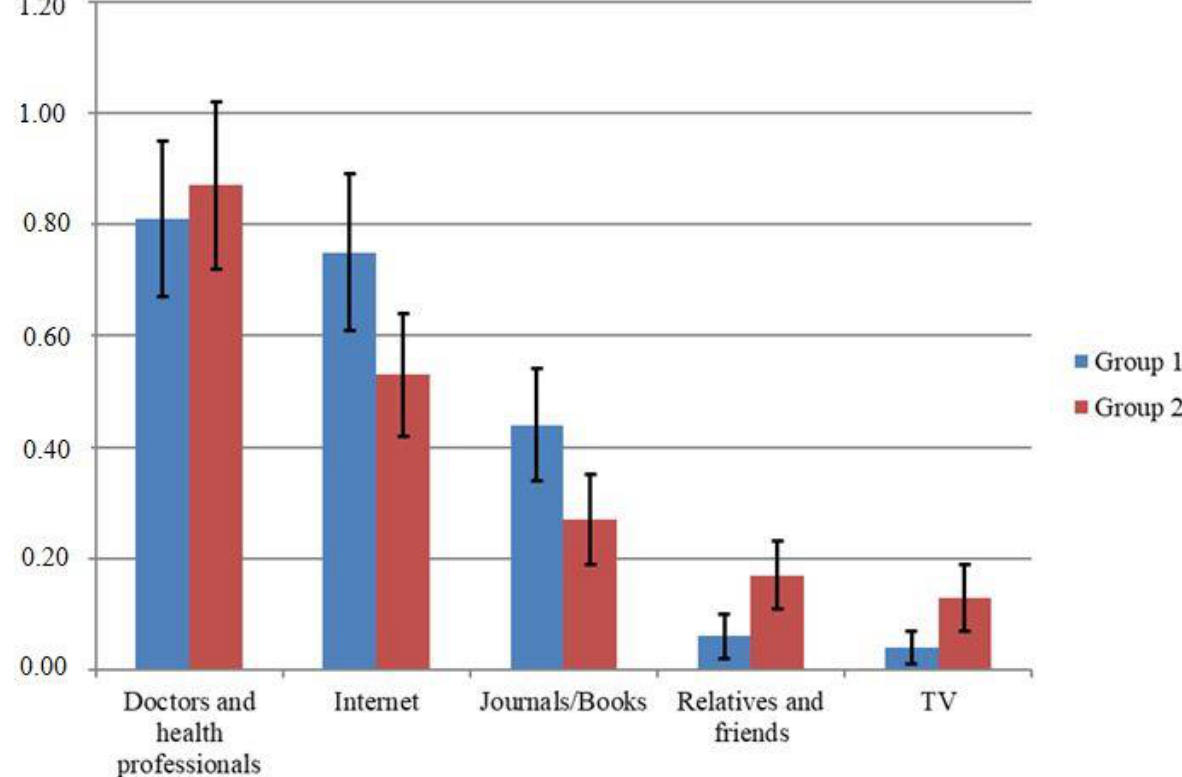
Figure 1. Sources sought for information about memory, dementia, and Alzheimer’s disease: proportion of answers. Question: “What is most important to get information about memory, dementia and Alzheimer’s disease?”- Answers: 1 — Doctors and health professionals (n :N =39; proportion=0.81; 95%CI 0.67– 0.95 vs. n :N =26; proportion =0.87; 95%CI 0.72–1.02; p=0.49). 2 — Internet (n :N =36; proportion=0.75; 95%CI 0.61–0.89 vs. n :N =16; proportion=0.53; 95%CI 0.42–0.64; p=0.04). 3 — Journal/books (n :N =21; proportion=0.44; 95%CI 0.34–0.54 vs. n :N =8; proportion=0.27; 95%CI 0.19–0.35; p=0.13). 4 — Relatives and friends (n :N =3; proportion=0.06; 95%CI 0.02–0.1 vs. n :N =5; proportion=0.17; 95%CI 0.11–0.23; p=0.19). 5 — TV (n :N =2; proportion=0.04; 95%CI 0.01–0.07 vs. n :N =4; proportion=0.13; 95%CI 0.07–0.19; p=0.14). Z-test for proportions was used to obtain p values.